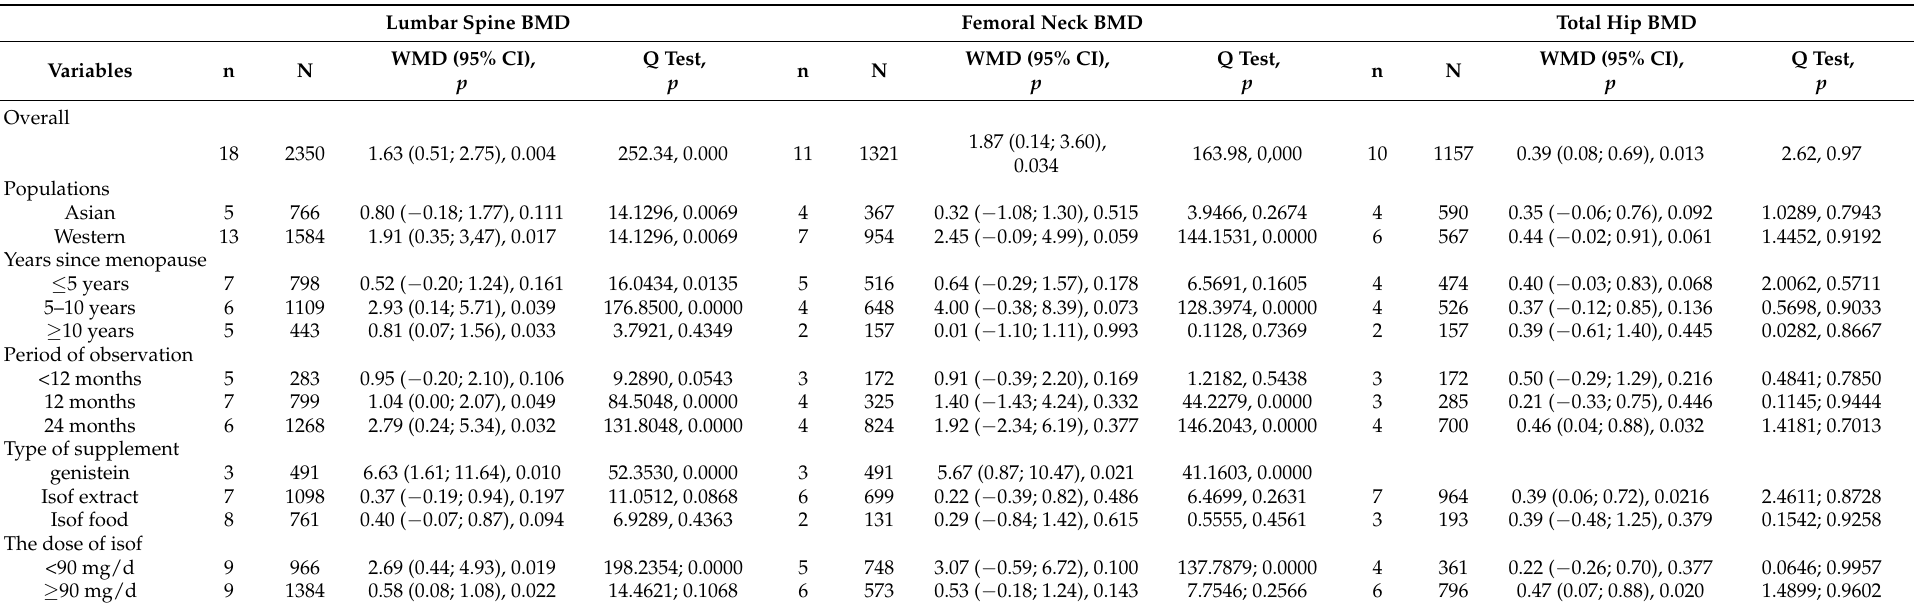
Table 2. Analysis in subgroups of the effect of soy isoflavones on bone mineral density in postmenopausal women. Lumbar Spine BMD Femoral Neck BMD Total Hip